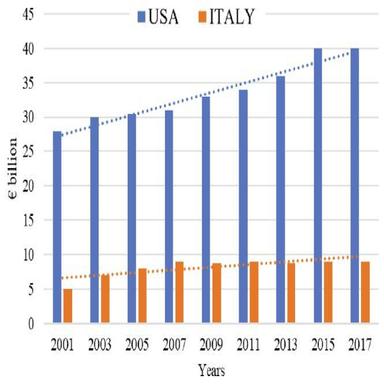
Comparison between the road maintenance funds allocation in Italy and USA countries.